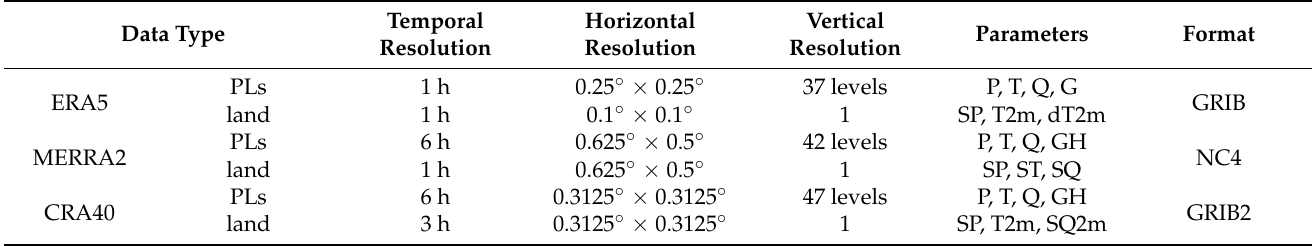
Table 1. Statistical table of the resolutions and parameters of three reanalysis data